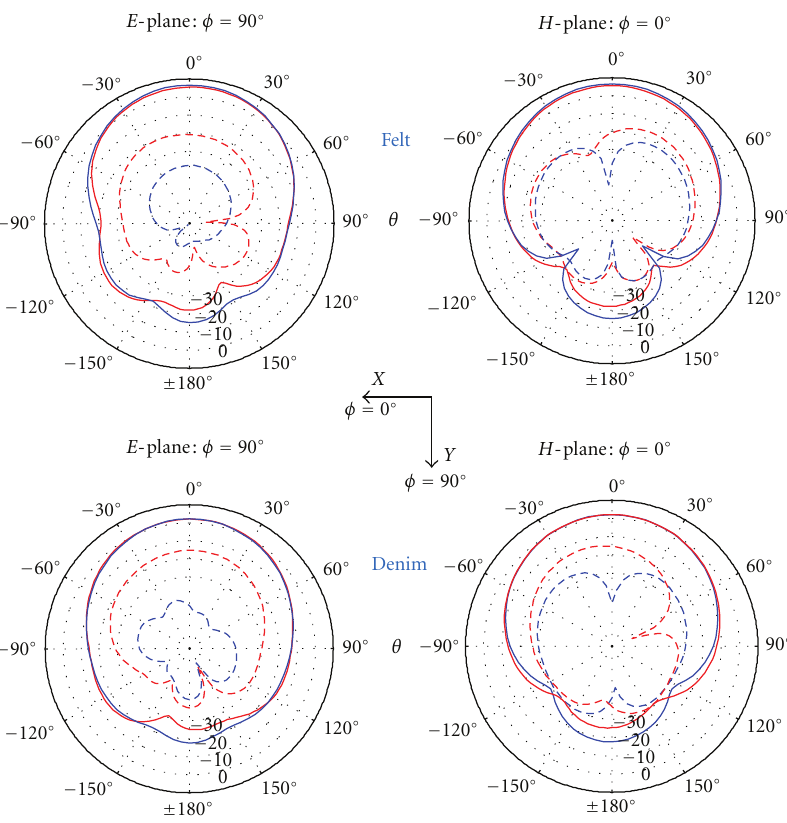
Figure 11: Radiation pattern of the patch antennas on felt ( f = 2.450 GHz) and denim ( f = 2.525 GHz) substrates. Solid curves present the principal polarization (PP) and the dotted ones the cross polarization (XP). Blue curves correspond to the simulation patterns and red curves to the measured ones.